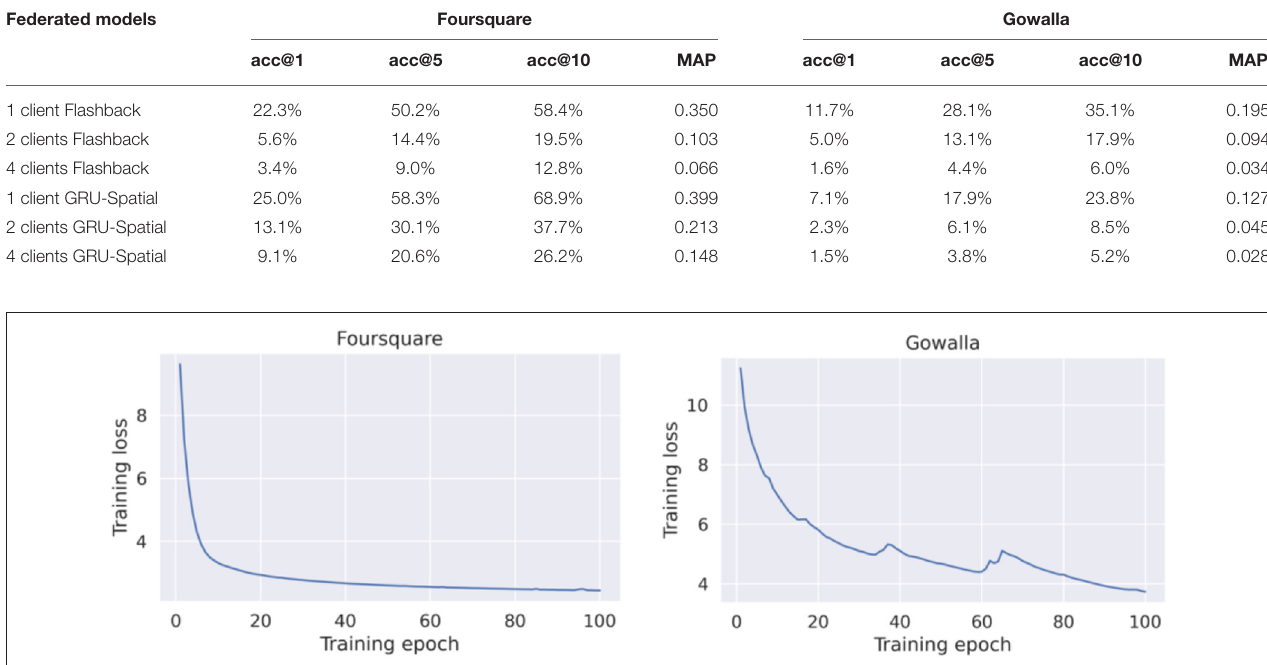
TABLE 3 | Federated results (10 rounds − 10 epochs).